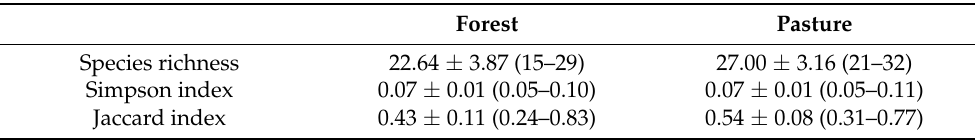
Table 3. Alpha and beta diversity between forest and pasture points in terms of the species richness, Simpson index, and Jaccard similarity